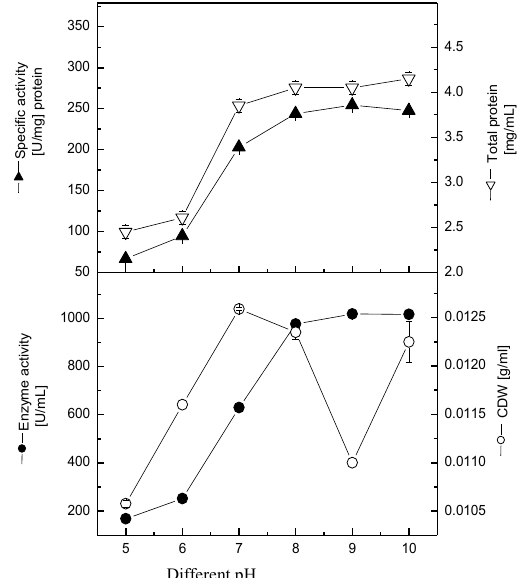
Figure 6. Effect of different pH on the production of alkaline protease produced by Str. pseudogrisiolus NRC-15 on 200 rpm at 96